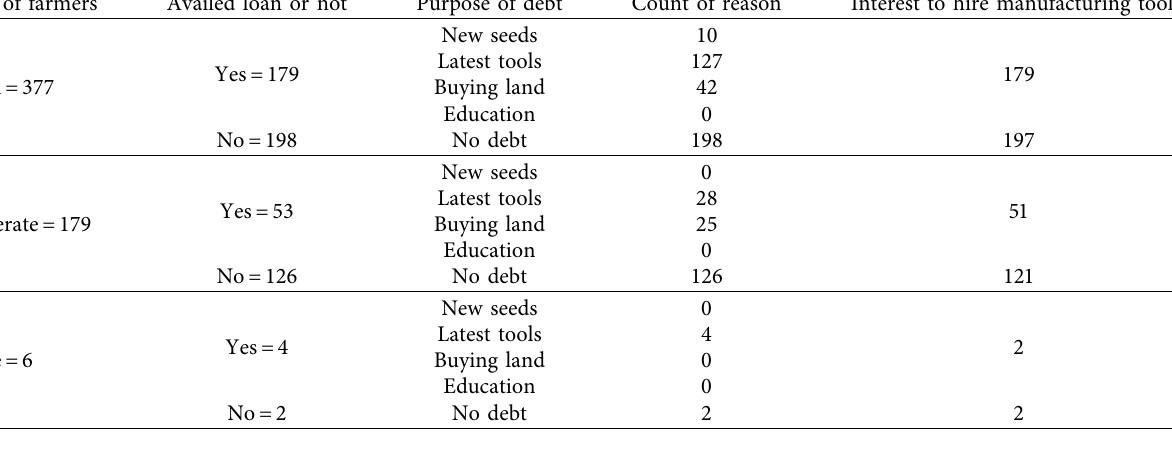
Table 6: Interpretation between the type of farmers and they availed loan or not with reason and their interest to hire manufacturing tools. Type of farmers Interest to hire manufacturing